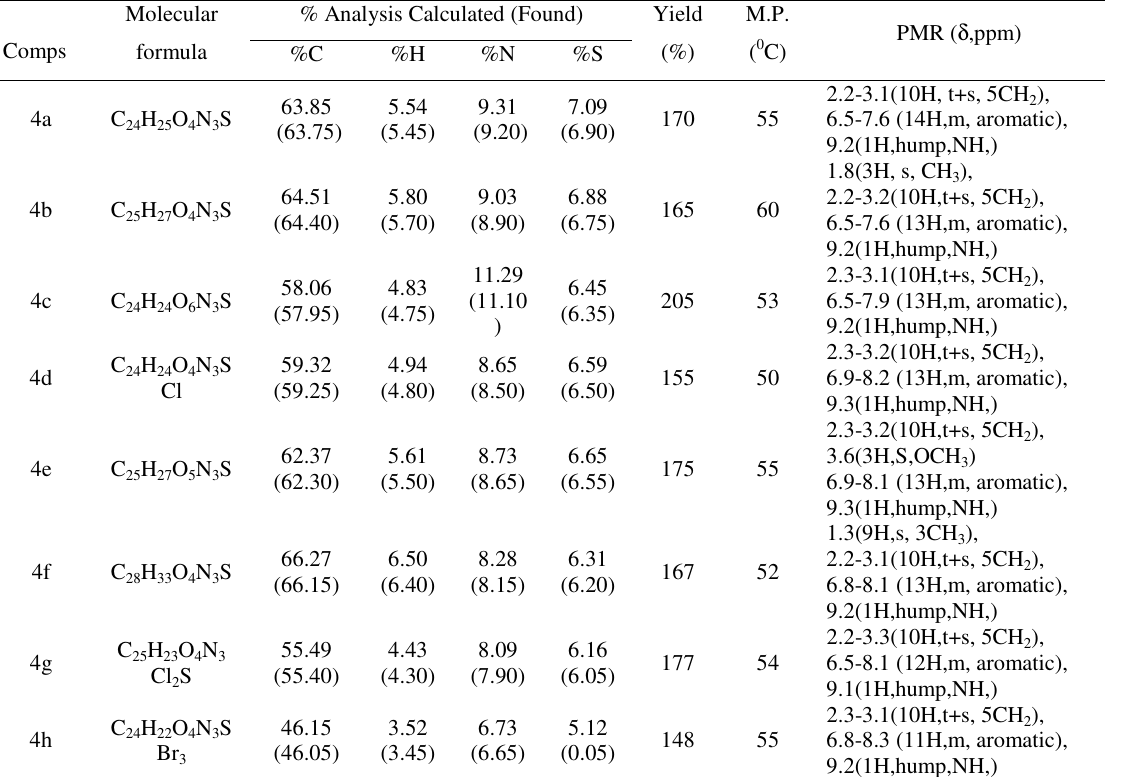
Table – 2. Analytical and Spectral data of Compounds